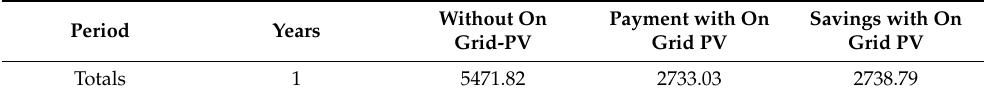
Table 7. Comparison of actual consumption and the photovoltaic system in USD.